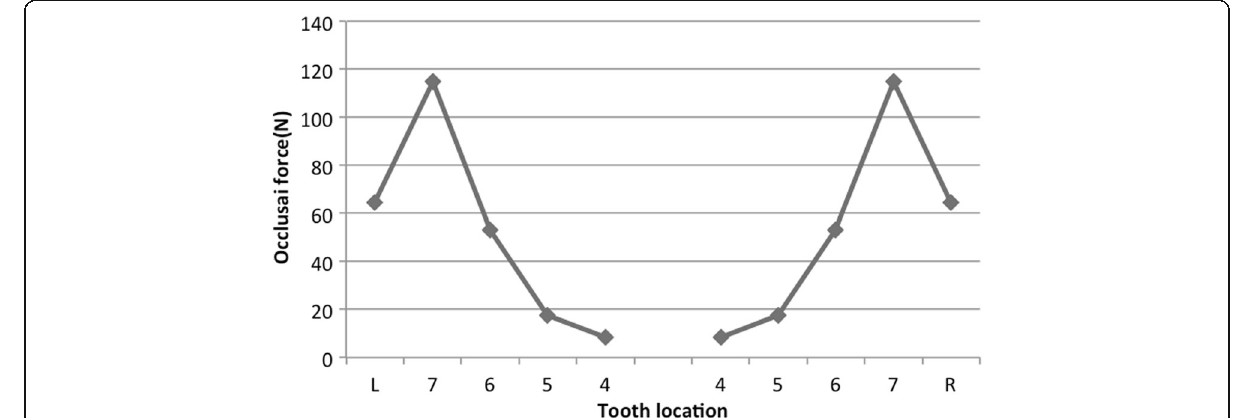
Fig. 5 Distribution of occlusal force in the natural teeth model displayed in